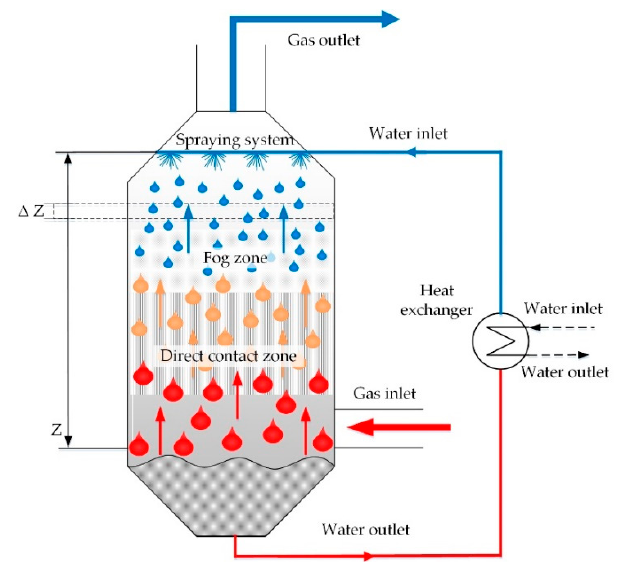
Figure 1. Scheme of fog unit flows.